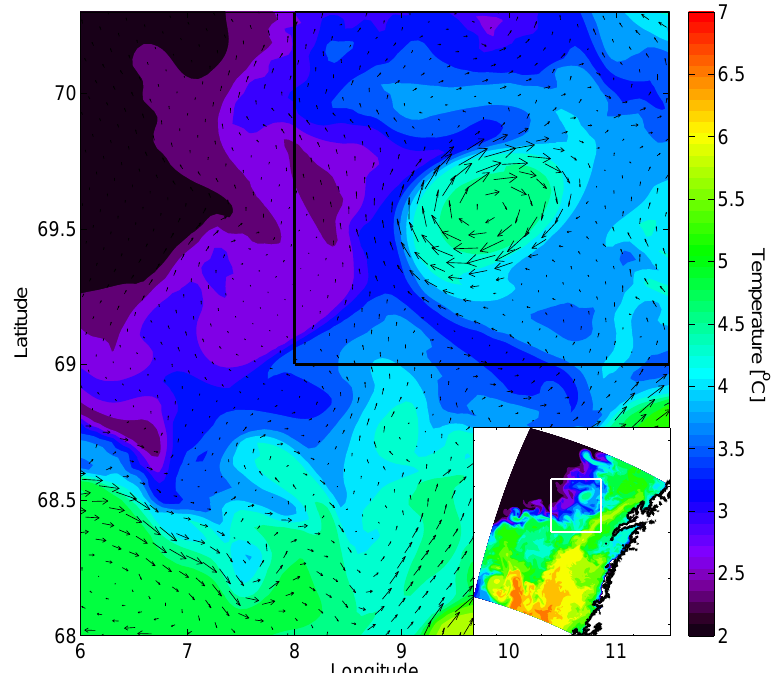
Fig. 1. Surface temperature and currents in the area of the eddy on 21 March 1999, which is the initial day of the particle simulation. The eddy is at this point fairly isolated from other mesoscale activity in the area. The particles at depth were released within the area shown, while the black rectangle indicate the initial area covered by the surface particles. Inserted: The surface temperature of the entire model domain, the white rectangle indicates the area shown in the large